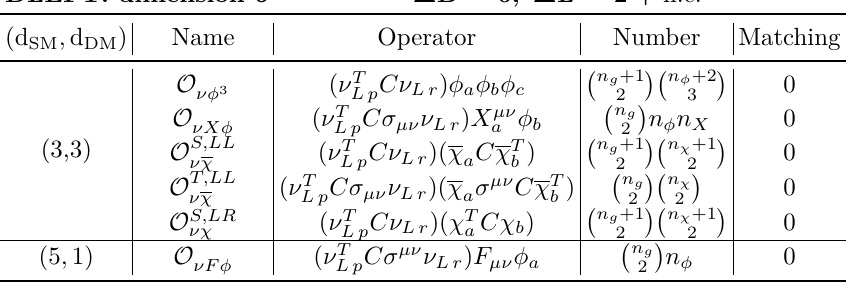
Table 31 . Dimension-six ∆ B = 0 , ∆ L = 2 operators in DLEFT. The first column gives the dimensions of the SM and DM part of the operator, the fourth column is the number of operators, and the fifth column is the additional matching contribution at the EW scale.